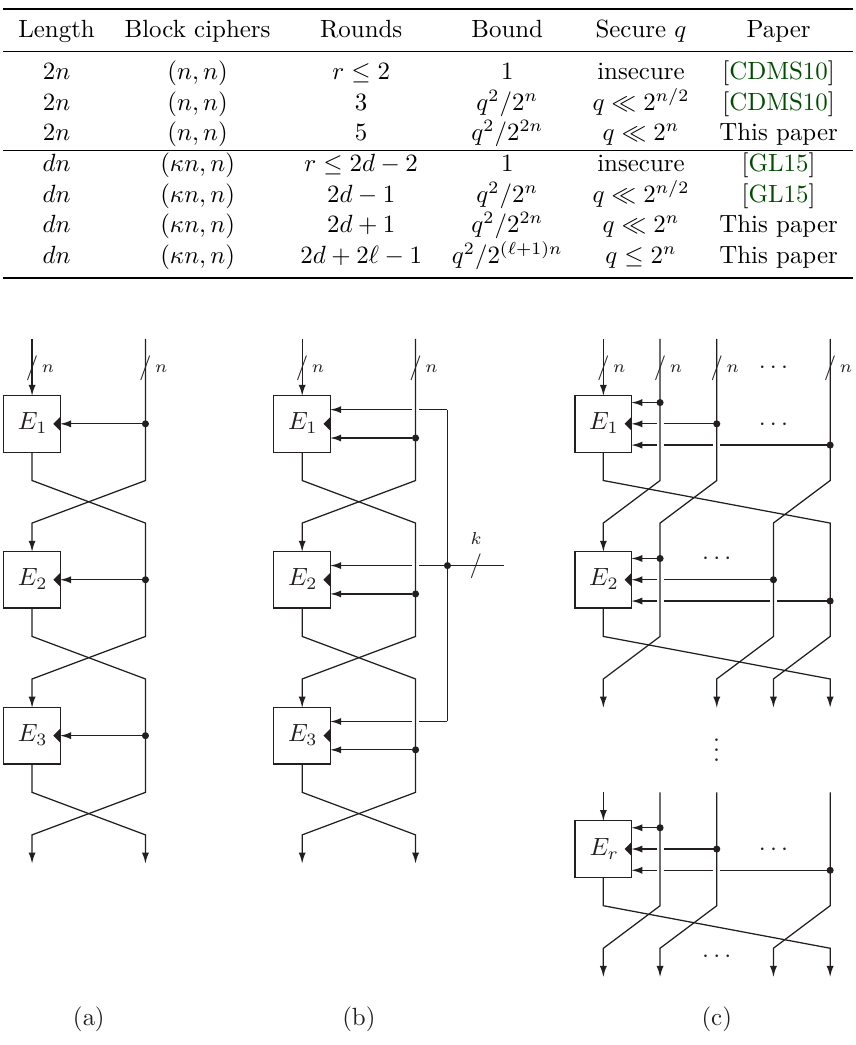
Figure 1: The constructions of previous works and the construction we study in this paper. (a) and (b) are Coron et al.’s constructions [CDMS10], and (c) for r = 2 d Lin’s construction (and k = 0) [GL15]. We prove the security of (c) for r = 2 d + 2 ‘ ‘ d and 1 ≤ ≤ −